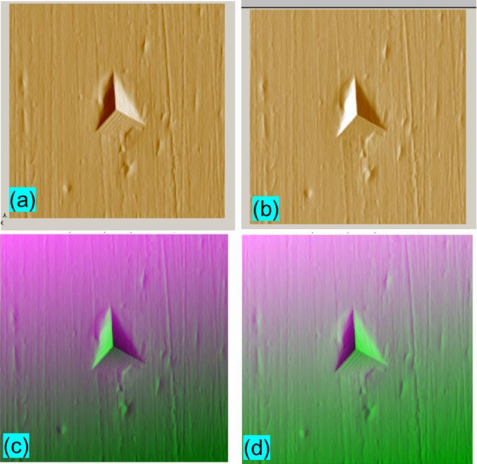
Figure 4. ( a , b ): System-generated image [26,27]; ( c , d ): recreated image from raw hierarchical data format (HDF) files generated by the system for maximum applicable load of 2000 µ N and 30 s holding